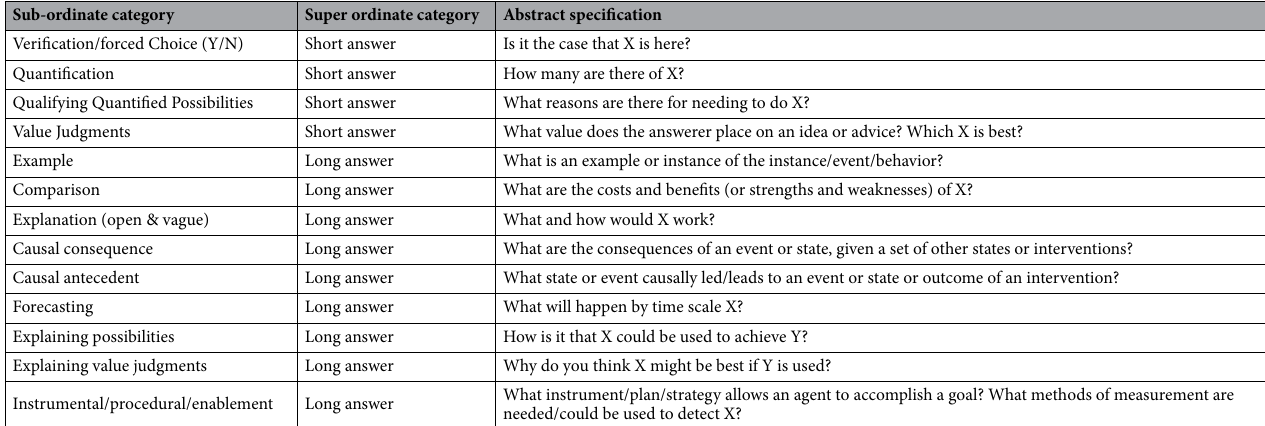
Table 3. The Revised Taxonomy of Question Styles. This table sets out the Revised Taxonomy of Question Styles, along with their abstract specifications.